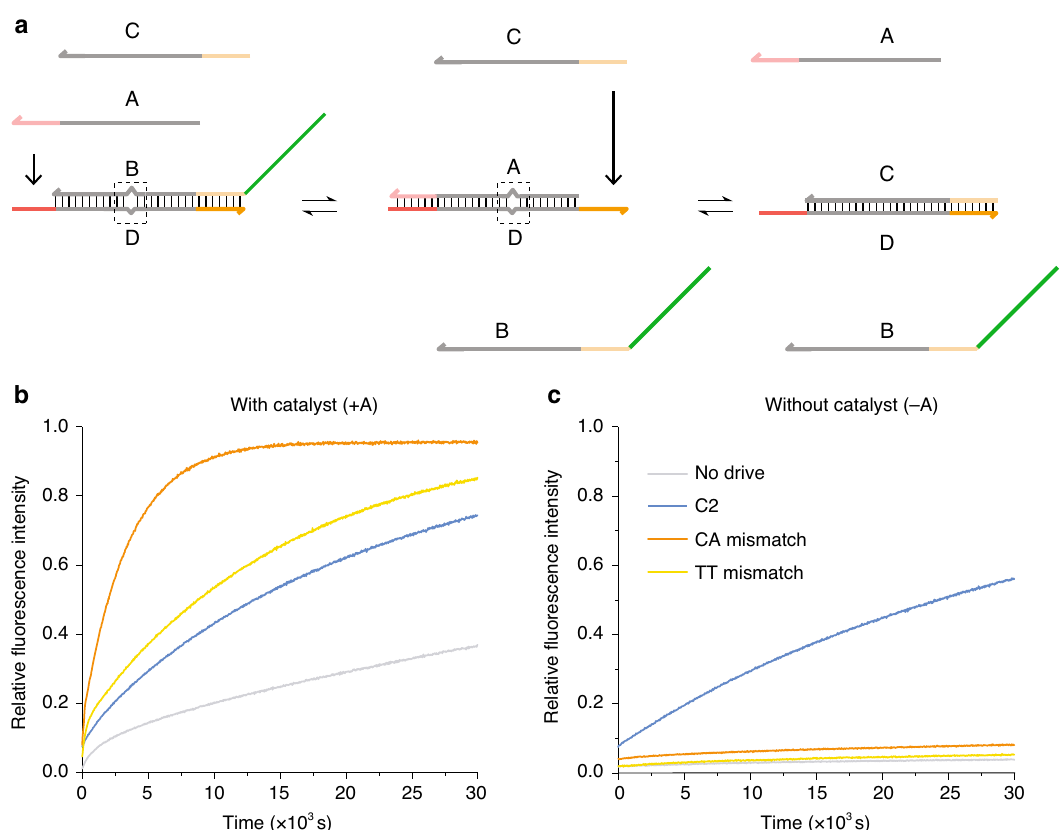
Fig. 5 Mismatch elimination can provide hidden thermodynamic driving. a Schematic of mismatch elimination during toehold exchange; a mismatch in the BD duplex is retained in the AD duplex, but eliminated in the fi nal CD duplex. b Normalized fl uorescence of a reporter for single-stranded B after 40 nM of BD is mixed with 200 nM of C and triggered by addition of 5 nM of catalyst strand A . Reactions presented are a no-mismatch system in which BD and CD have the same number of base pairs (no drive), a variant with a strand C 2 that can form two additional base pairs with D (C2), and two systems in which modi fi ed A and B strands form C – A and T – T mismatches with D that are eliminated in the CD duplex. These mismatches are positioned 12 and 11 base pairs, respectively, from the end of the AD duplexes. The systems in which mismatch elimination is used to provide a thermodynamic drive show strongly enhanced reaction rate and yield. c Monitoring of leak reactions in systems that are equivalent to b , but without the addition of the catalyst strands. The mismatch elimination systems show leak reaction rates that are comparable to the no drive system and much lower than the C 2 variant. Each curve shows a single experiment; a second replica is reported in Supplementary Fig.